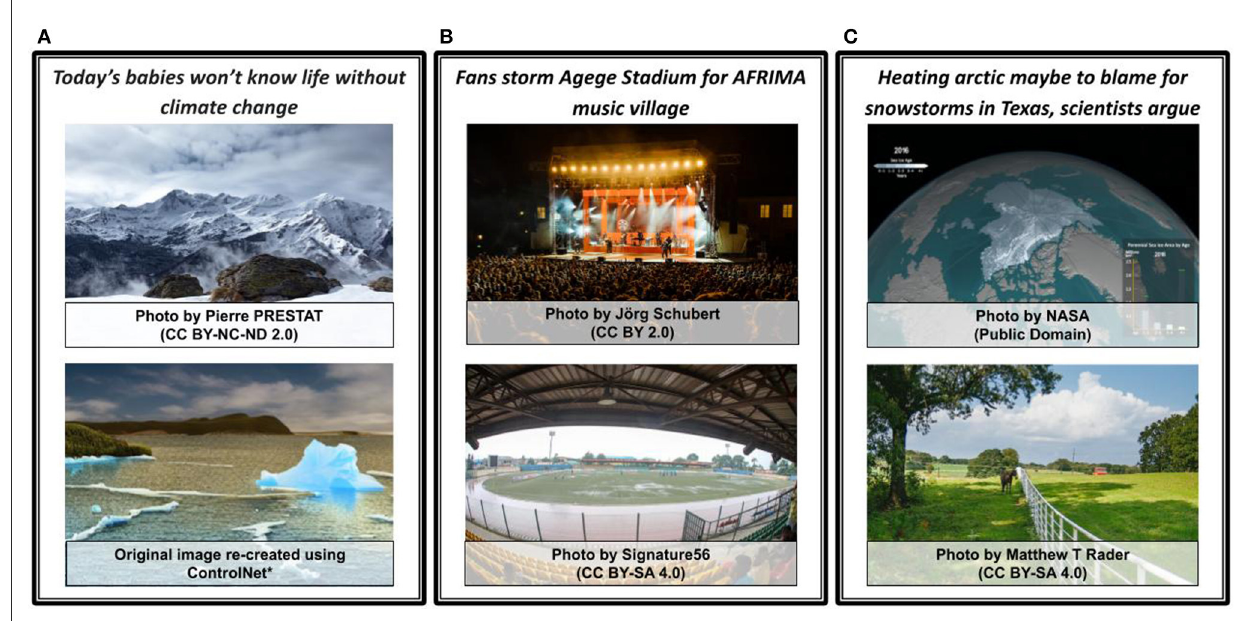
Figure 7H is such an example where the table in the